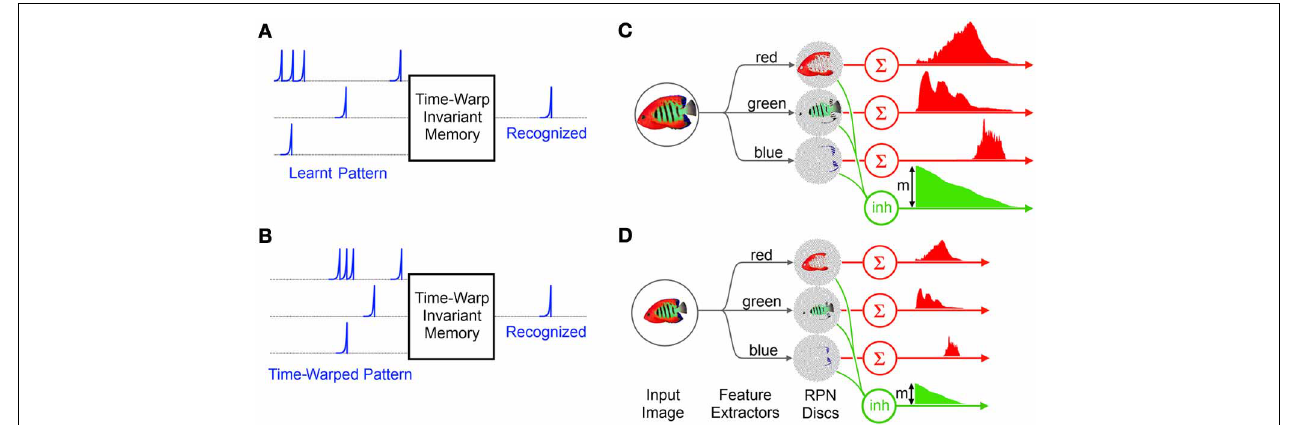
FIGURE 6 | Time Warp invariant memory network and the RPN’s scale invariance: (A) the memory network learns a particular spatiotemporal pattern (B) The memory network recognizes a time warped version of the learnt pattern (C) The RPN system generates a spatio-temporal pattern from the projected image of reef fish via simple color based